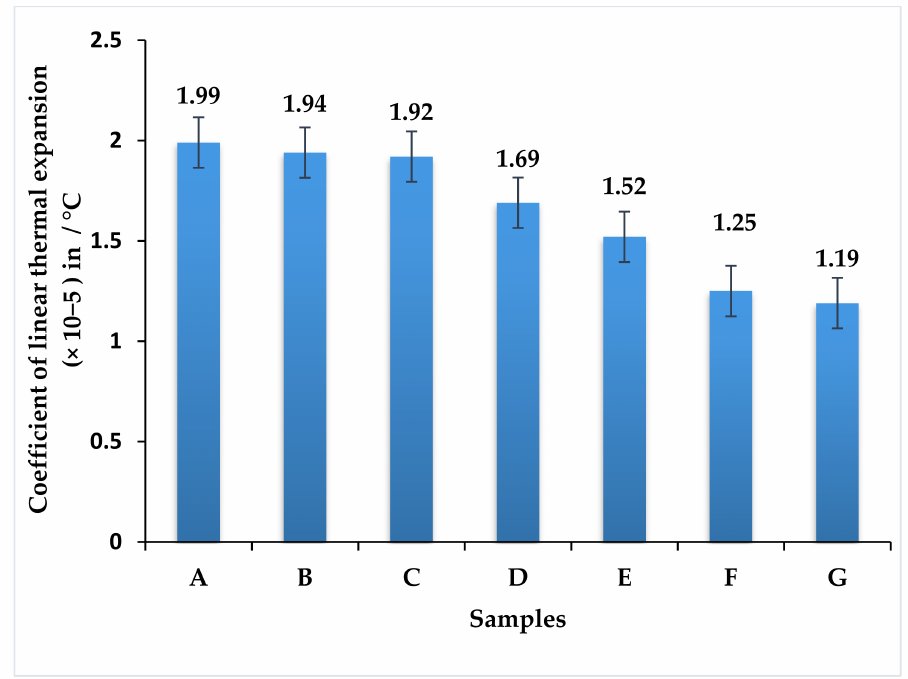
Figure 7. The thermal expansion coefficient of hybrid epoxy